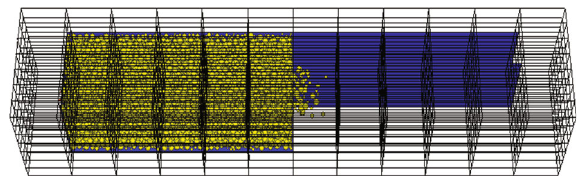
Figure 5: Schematic diagram of fl uid unit